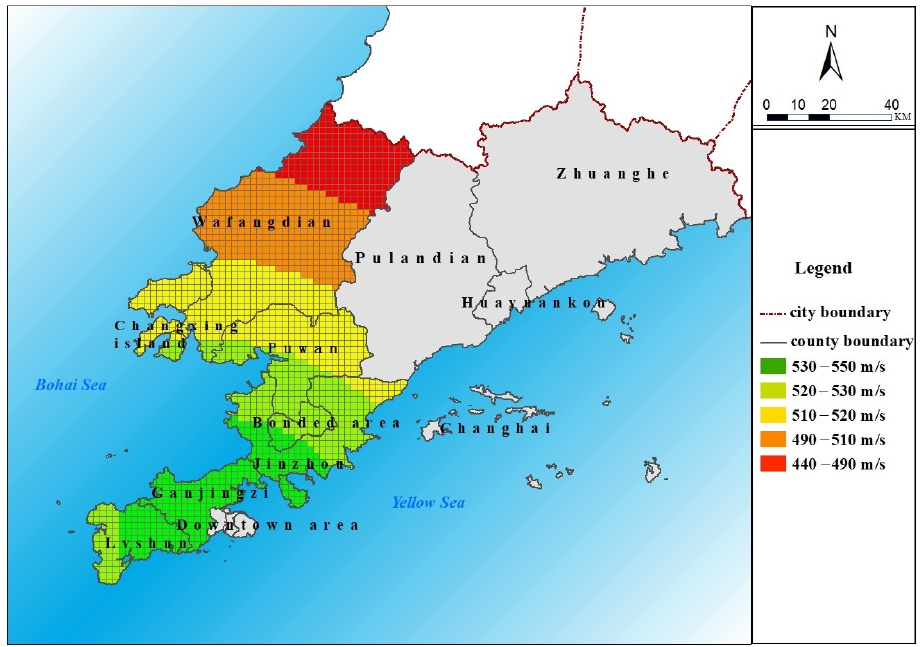
Figure 3. The average accumulated wind speed of Dalian City from 2010–2018.